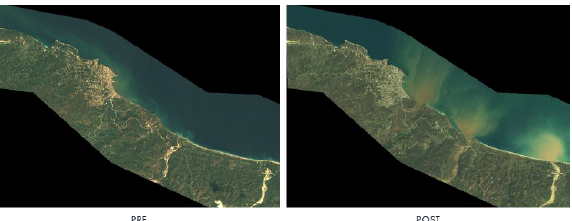
Figure 4. Haiti, pre and post Matthieur Huricane (oct 16), pansharpened Pleiades